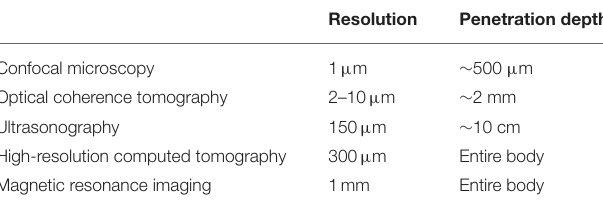
TABLE 1 | Pros and cons of skin biopsy and dermoscopy. Skin biopsy Dermoscopy